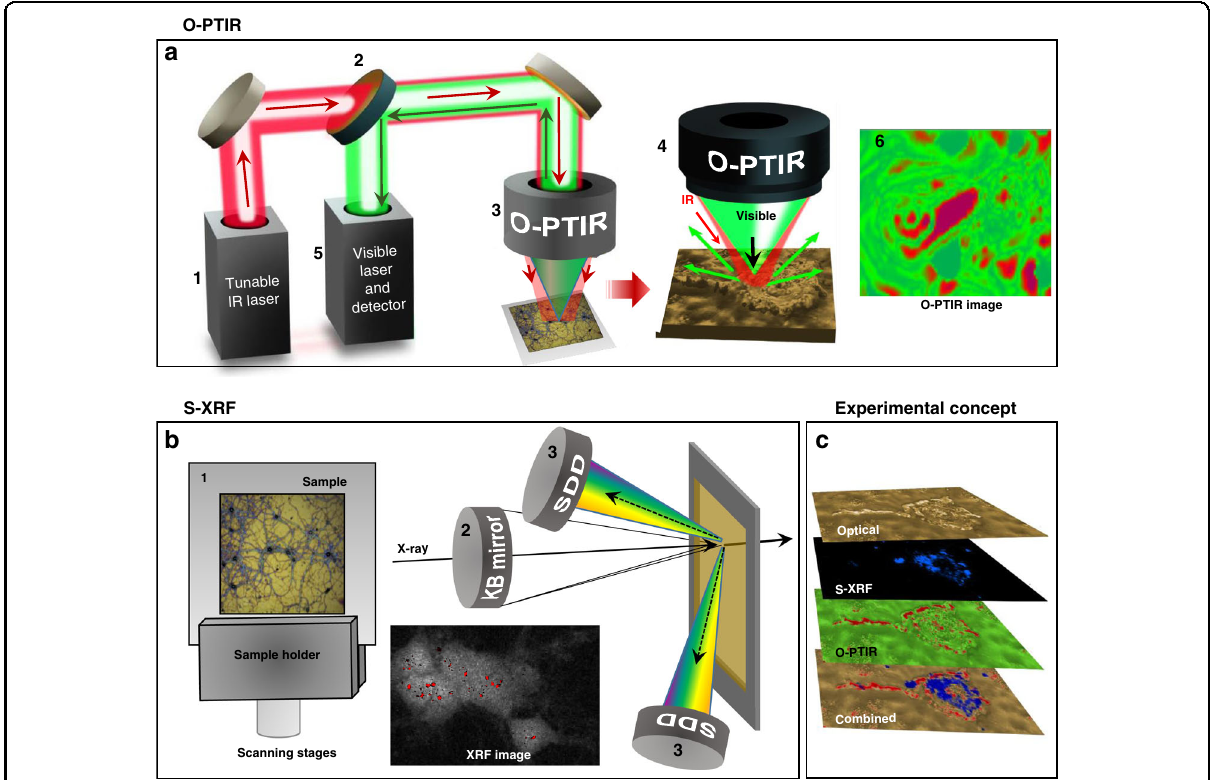
Fig. 1 Sample preparation and experimental setup. a O-PTIR setup: a pulsed, tunable IR laser is guided onto the sample surface (1). The IR laser is made collinear with the green 532 nm detection laser (2). The collinear beams are focused on the sample surface through a microscope objective (3). When IR absorption occurs, the photothermal response of the sample is monitored by the scattered green light (4). The re fl ected green light returns to the detector, and the IR signal is extracted (5), and an infrared image is produced (6). b X-ray fl uorescence nanoimaging of individual neuronal cells deposited on Si 3 N 4 (1). The sample is scanned by the nanofocused beam produced by the Kirkpatrick – Baez nanofocusing mirror pair (2), while the X-ray fl uorescence signal is being collected by two Si drift detectors (3). S-XRF image shows the distribution of iron at a sub-cellular level. c Conceptualization of the data analysis based on superimposed optical, O-PTIR, and S-XRF